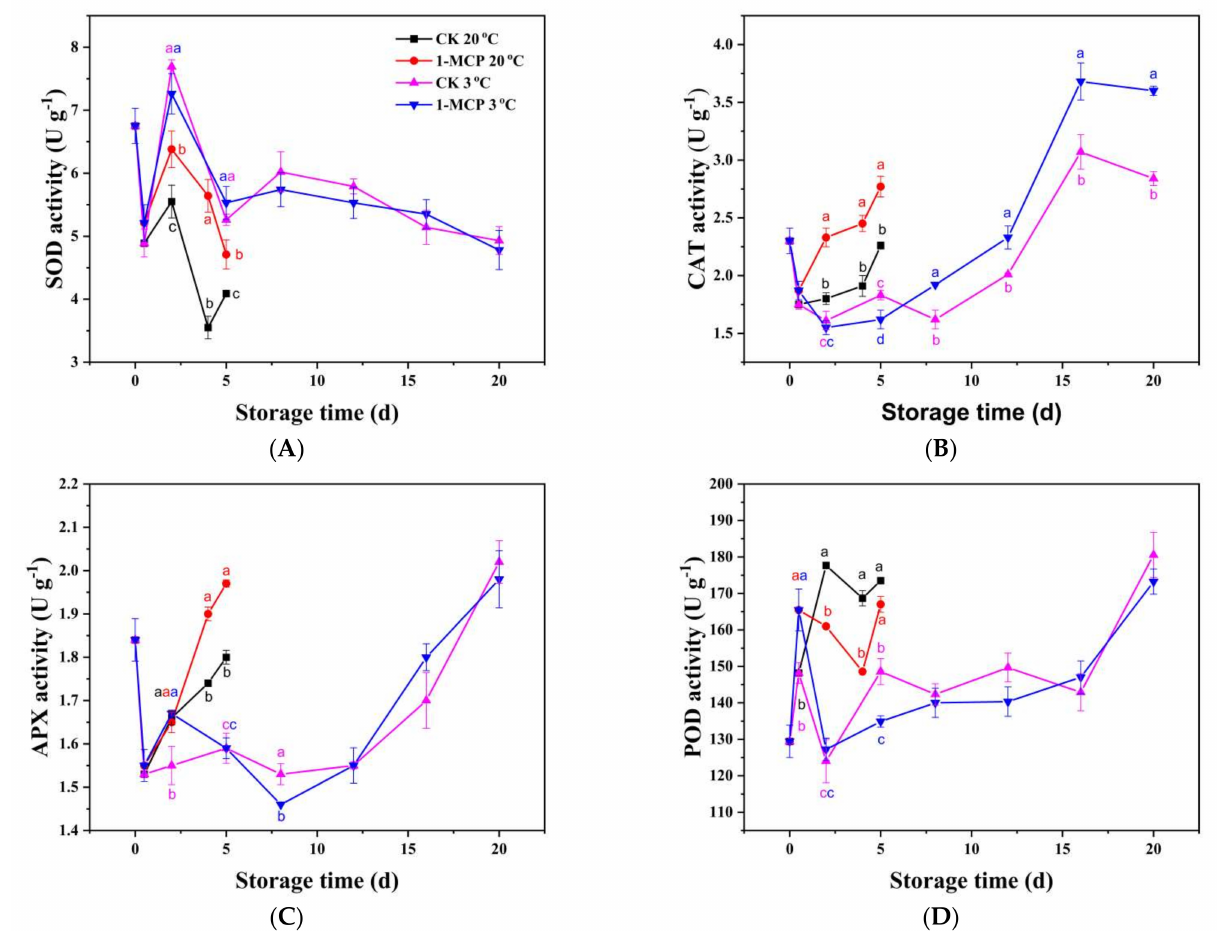
Figure 4. SOD activity ( A ), CAT activity ( B ), APX activity ( C ) and POD activity ( D ) of 1-MCP treated and untreated chives during storage at 20 ◦ C and 3 ◦ C. Data are expressed as the mean of triplicate samples. Vertical bars represent the standard errors of the means. The different letters at each time point indicate a difference among the chives